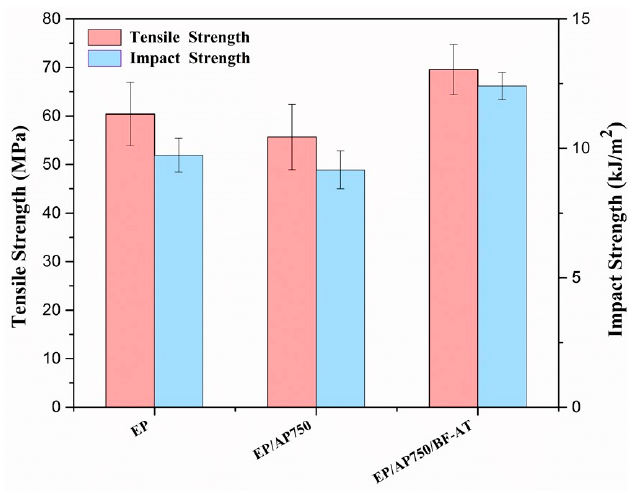
Figure 8. Tensile and impact results of EP, EP/AP750, and EP/AP750/BF-AT.